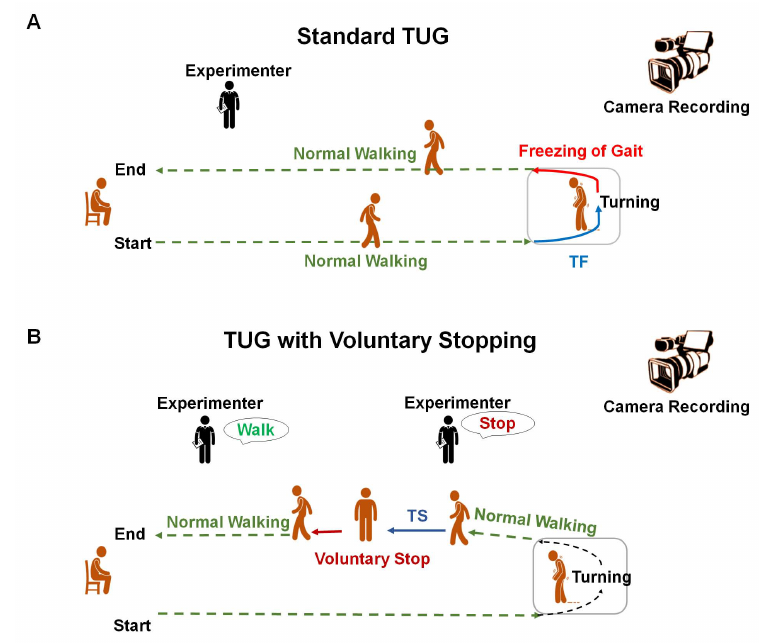
Figure 1. Experimental paradigm of ( A ) standard TUG task. ( B ) TUG task with verbal instructions to “stop” and “walk” to facilitate voluntary stopping. TF denotes the transition to FOG, and TS denotes the transition to voluntary stopping. Table 1. Participant-based count of normal walking, transition to FOG, and transition to volun- tary stopping.